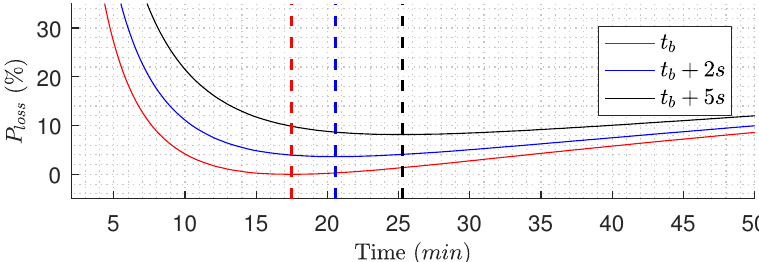
Figure 14. Estimated average flux loss as a function of time (Equation (17)) for different backwashing duration extensions, where the max ( j avg | n ( t )) term is the maximum j avg across time and different backwashing durations. The dashed lines are the optimal t f for the different backwashing durations—based on data from Figure 11.